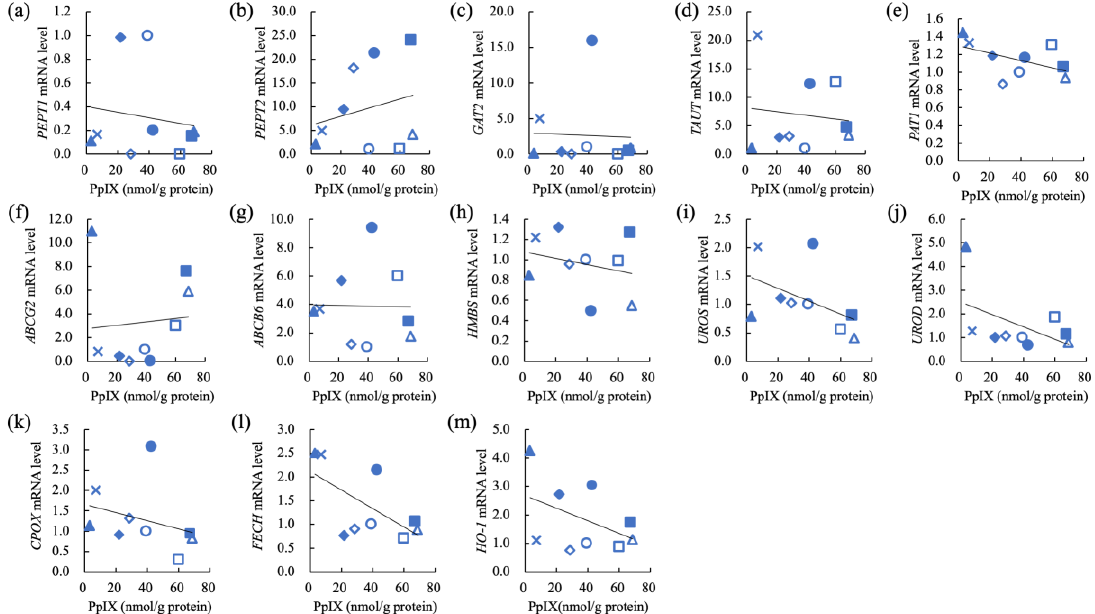
Figure 9. Correlation of intracellular PpIX concentration and relative mRNA levels in carcinomas. ( a ) Peptide transporter 1 (PEPT1), ( b ) peptide transporter 2 (PEPT2), ( c ) GABA transporter 2 (GAT2), ( d ) taurine transporter (TAUT), ( e ) H+/amino acid transporter 1 (PAT1), ( f ) ATP-binding cassette transporter G2 (ABCG2), ( g ) ATP-binding cassette transporter B6 (ABCB6, ( h ) hydroxymethylbilane